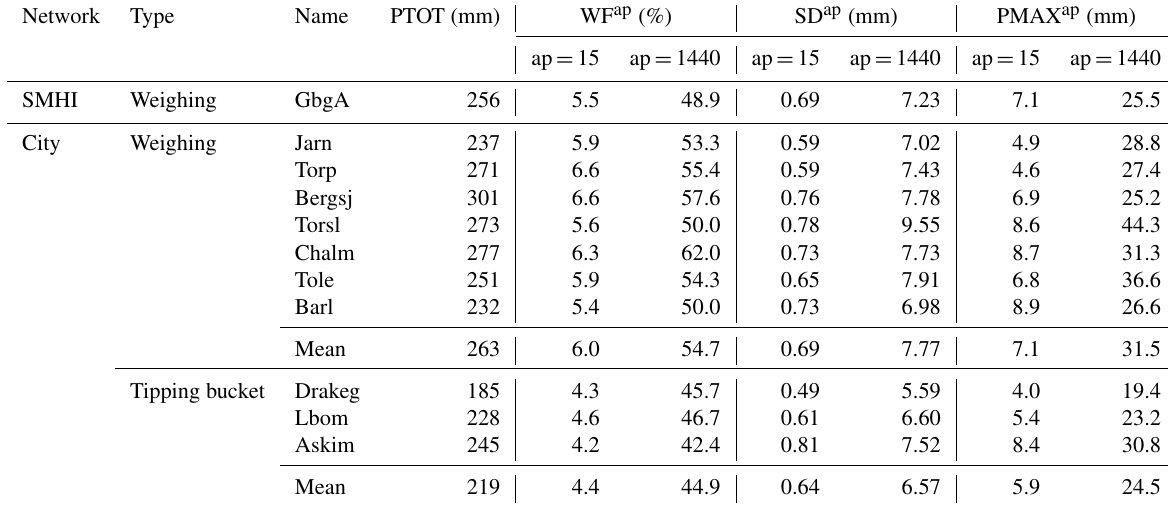
Table 6. Key rainfall statistics for the rain gauge observations during June–August 2015. For gauge locations, see Fig. 2.